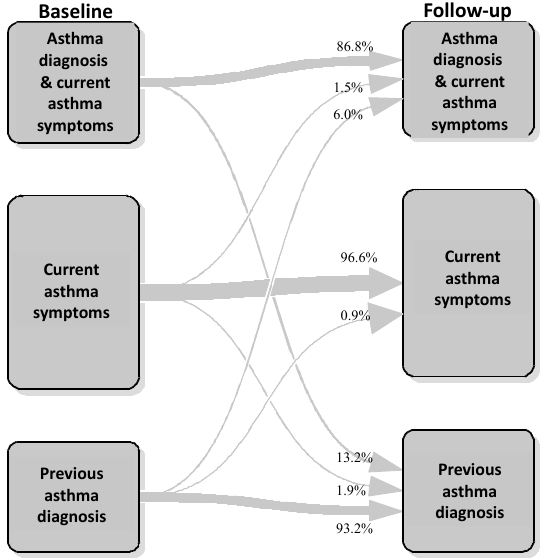
Figure 2. AGAVE phenotype transition plot.